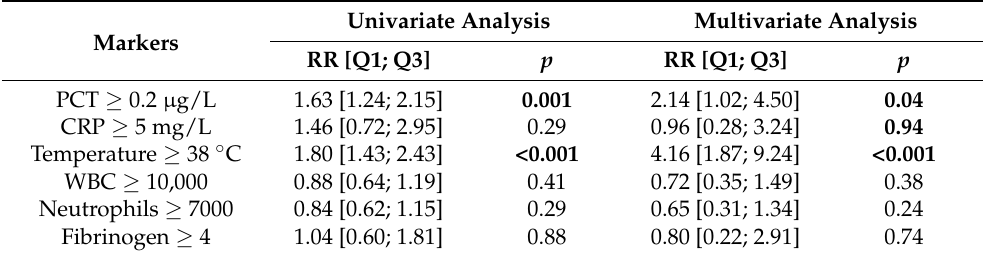
Table 3. Univariate and multivariate analyses of the relative risk of infection according to different clinical and biological parameters in the population of 74 patients with AAV.